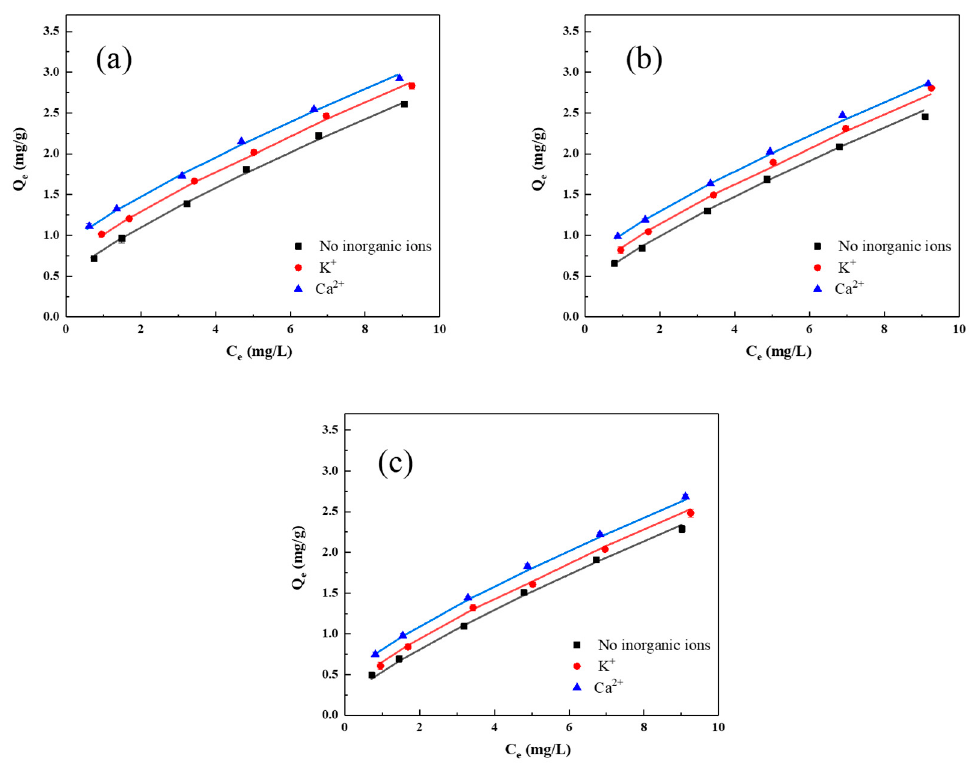
Figure 6. Results of fitting the Freundlich isotherm model to the experimental adsorption data: ( a ) 293 K, ( b ) 303 K, and ( c ) 313 K (the error bars represent the 95% confidence interval of the average values).